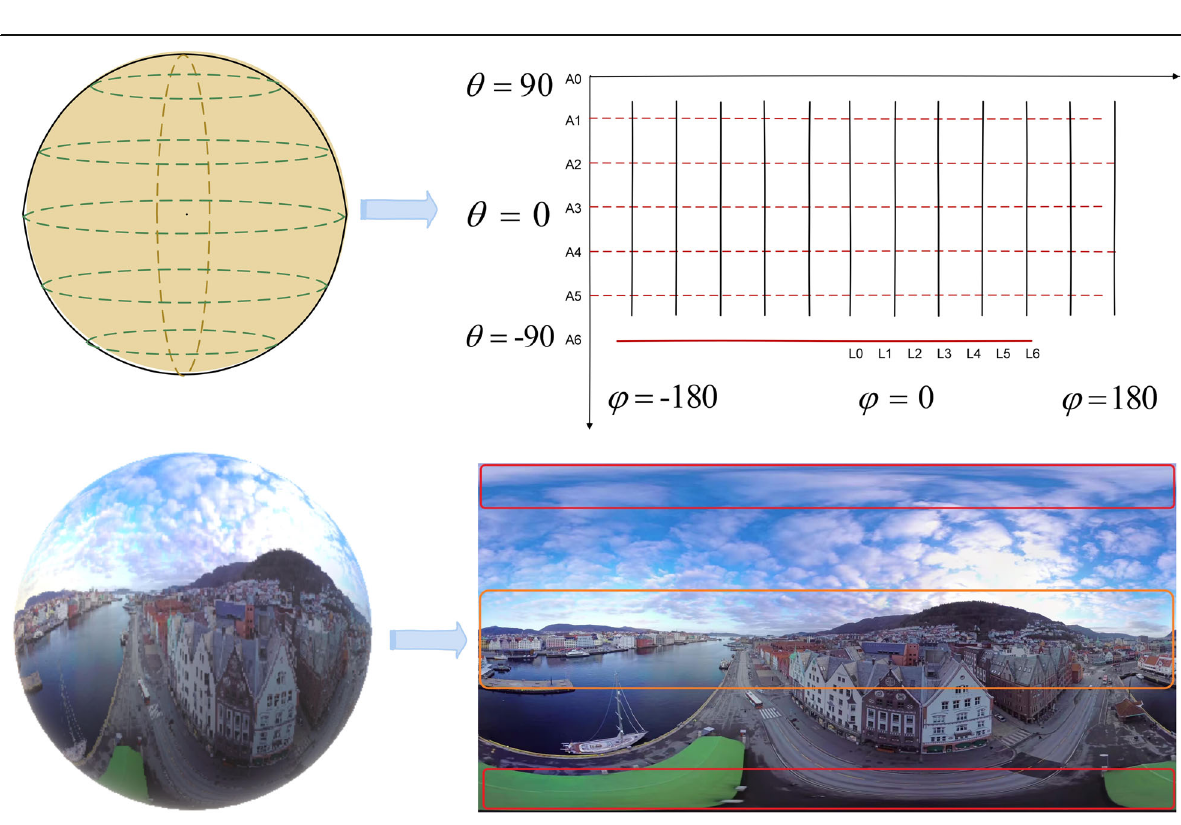
Fig. 4 ERP format: expands from spherical to